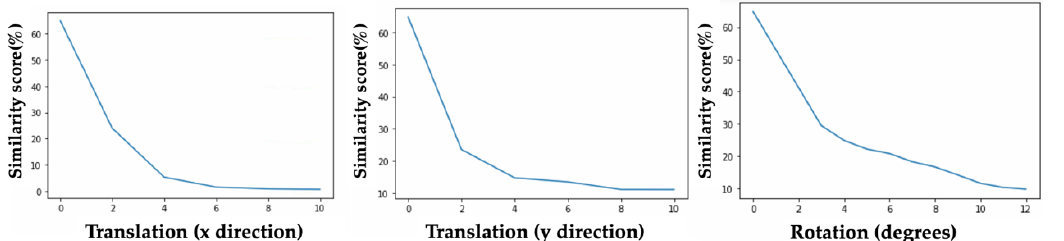
Figure 14. Sensitivity test results for Siamese network. Left — sensitivity to applied translation in the x direction, Middle — sensitivity to applied translation in the y direction, Right — sensitivity to applied rotation.